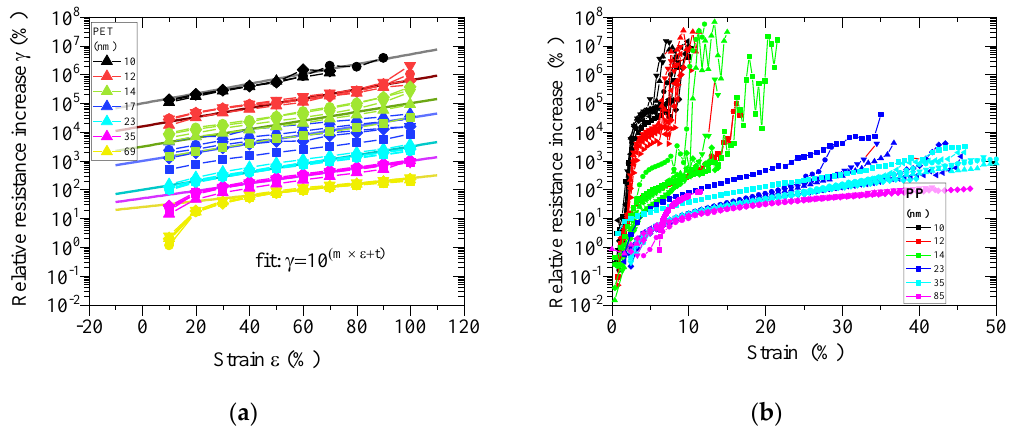
Figure 11. Effect of corona dosage E , aluminum thickness d and tensile strain ε on the increase in resistance γ of aluminum-coated polymer films under strain. Lines of same color represent the various different corona dosages. ( a ) PET films. ( b ) PP films.